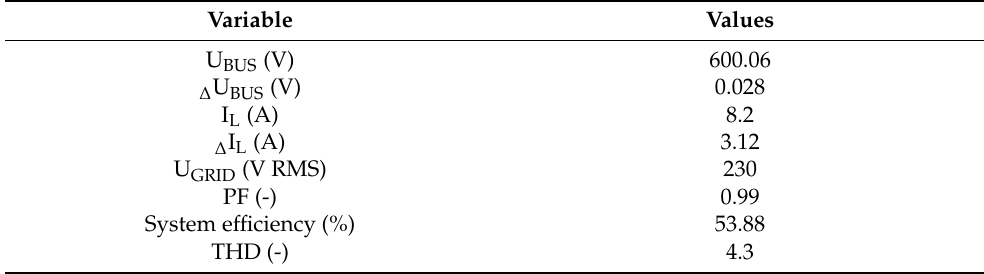
Table 2. Evaluation of the operational variables of the proposed DC microgrid during Scenario 1.